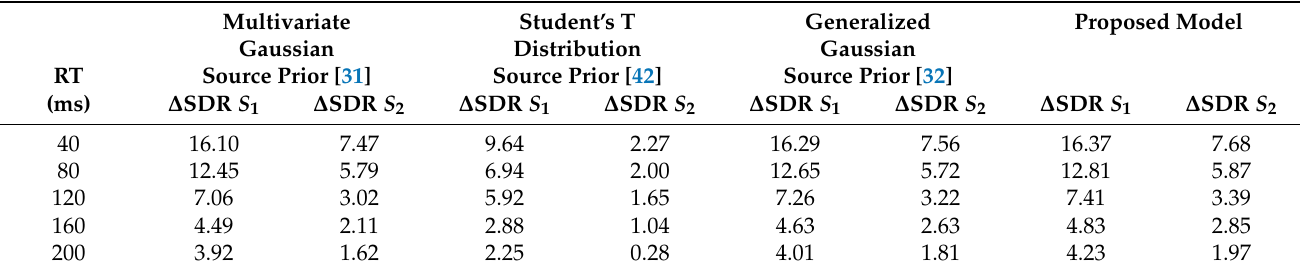
Table 2. Average RT results for the first proposed model shown in Figure 1 with variable RT for multistage BSS models having different source